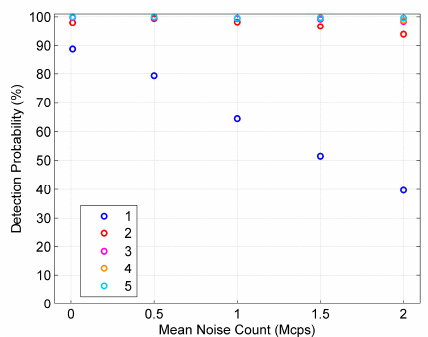
Figure 11. The influence of noise count on detection probability (1, 2, 3, 4, and 5 is the mean echo photon number).